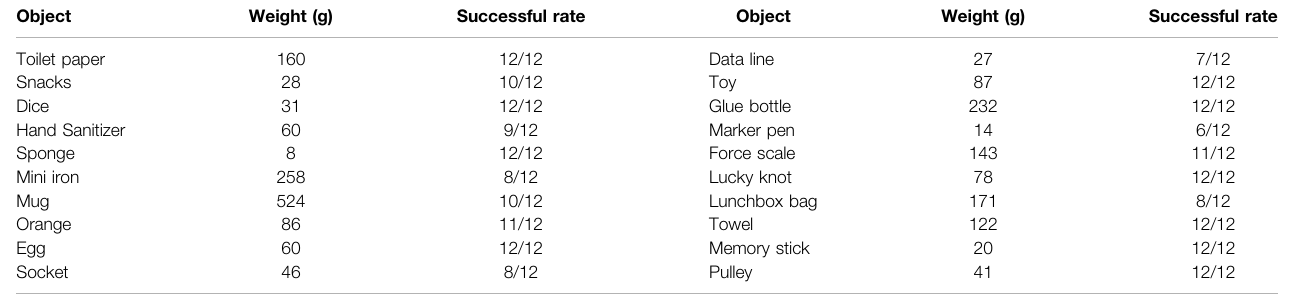
TABLE 3 | Everyday objects for grasping performance test and their successful grasping rate.